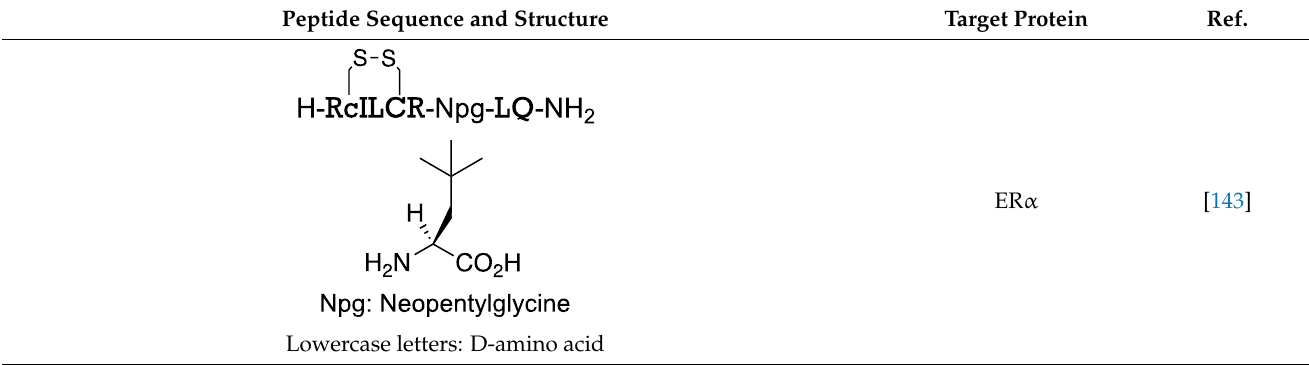
Table 7. Stapled PPI inhibitor peptides.